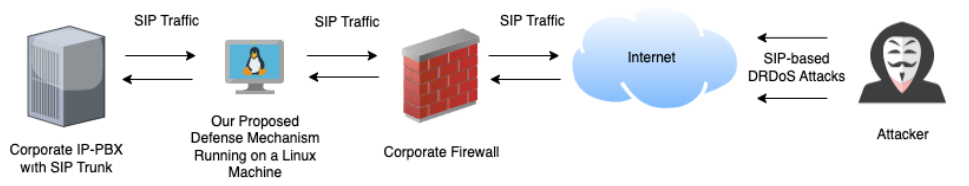
Figure 6. Placement of our proposed defense mechanism on the